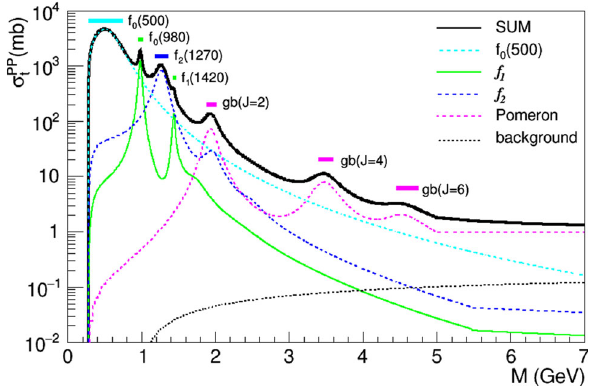
Fig. 8 Contributions of the f 0 (500) resonance, the f 1 , f 2 and the Pomeron trajectory, and of the background to the PP total cross sec- tion